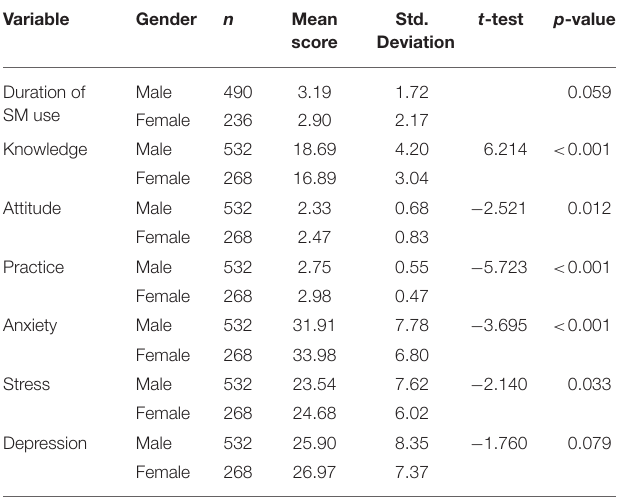
TABLE 2 | Comparison of duration of social media use, knowledge, attitude, and practices regarding the coronavirus disease 2019 (COVID-19), and anxiety, depression, and stress levels between the genders ( n = 800).